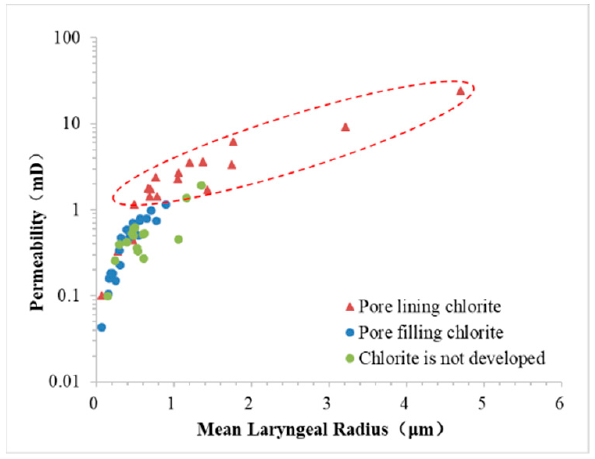
Figure 13. Controlling effect of chlorite development on laryngeal radius.